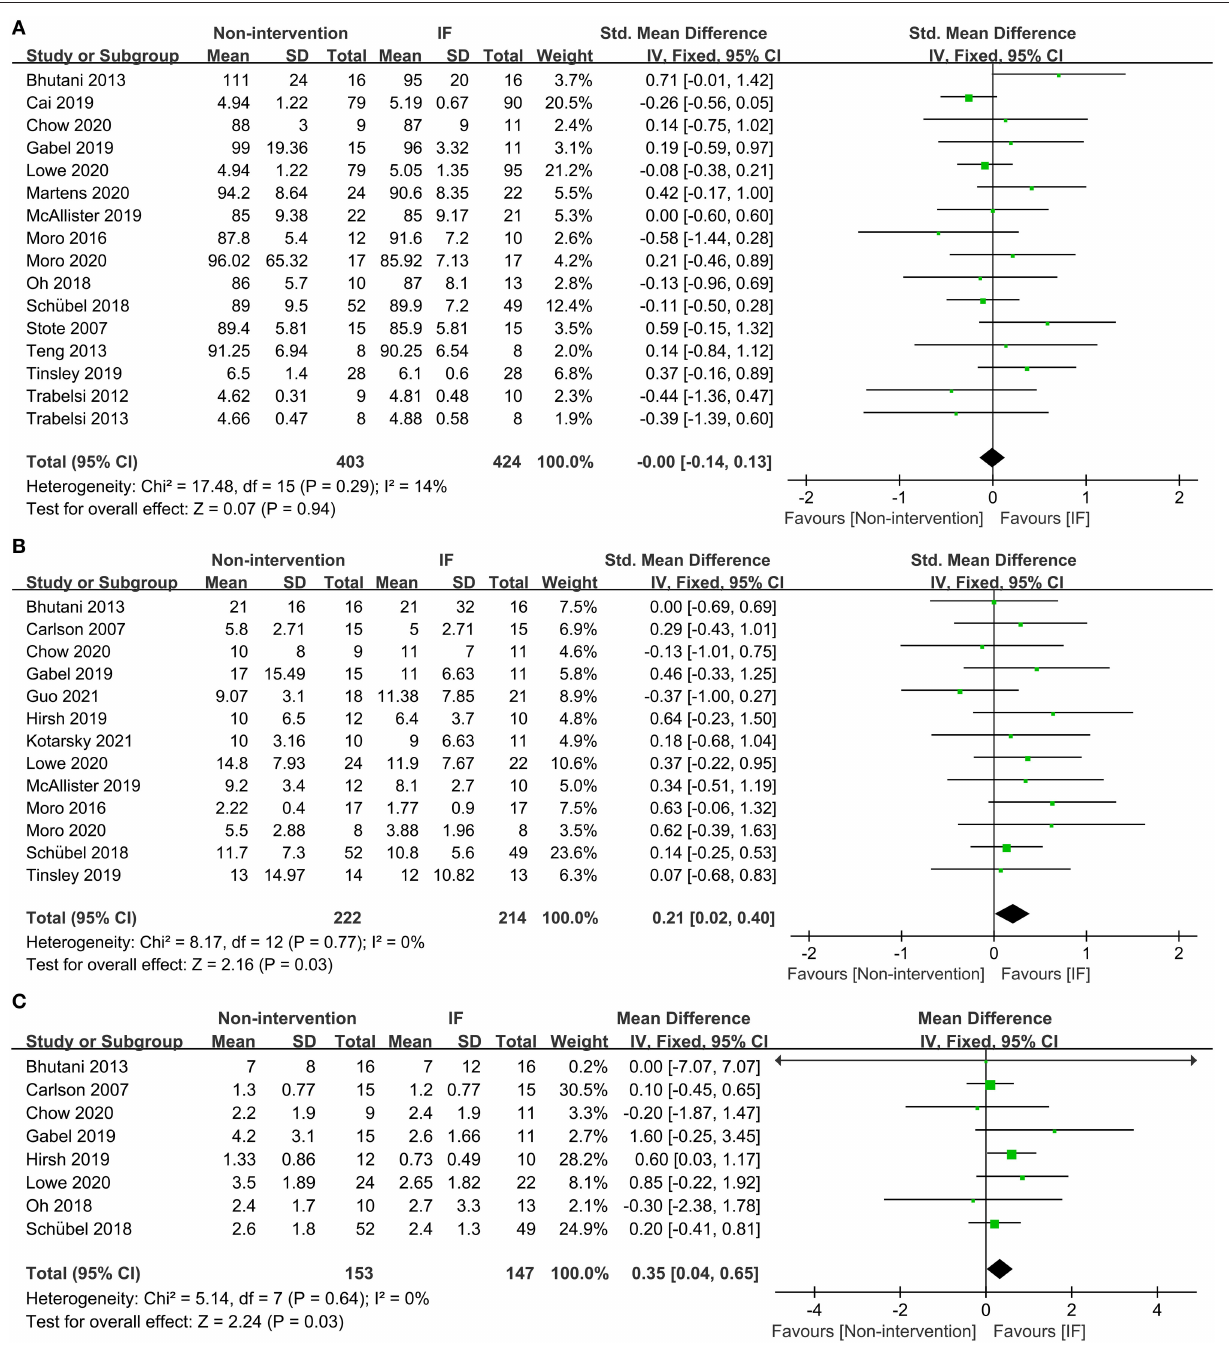
high dropout rate (in contrast to CR, IF had a 38% dropout rate) (61,